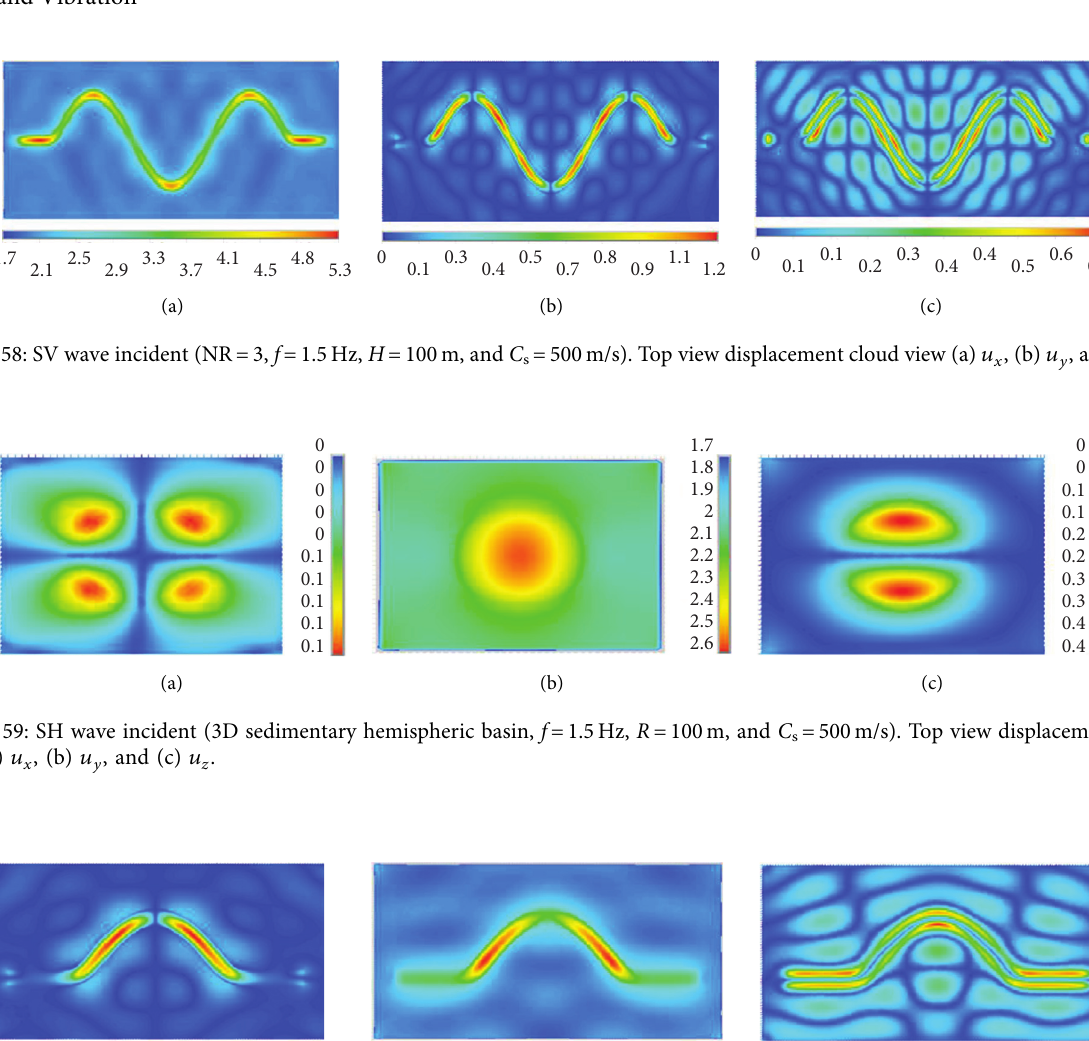
� 500m/s). Top view displacement cloud view (a) u s